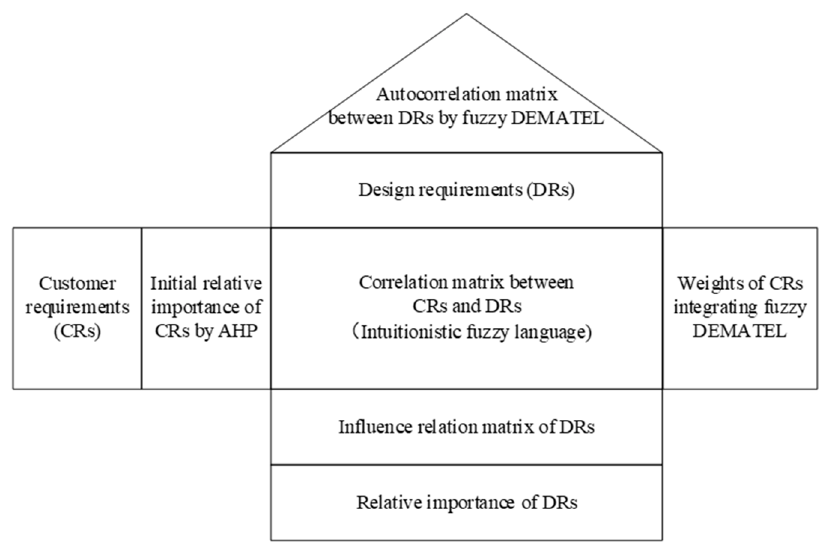
Figure 1. HOQ based on the fuzzy DEMATEL method.